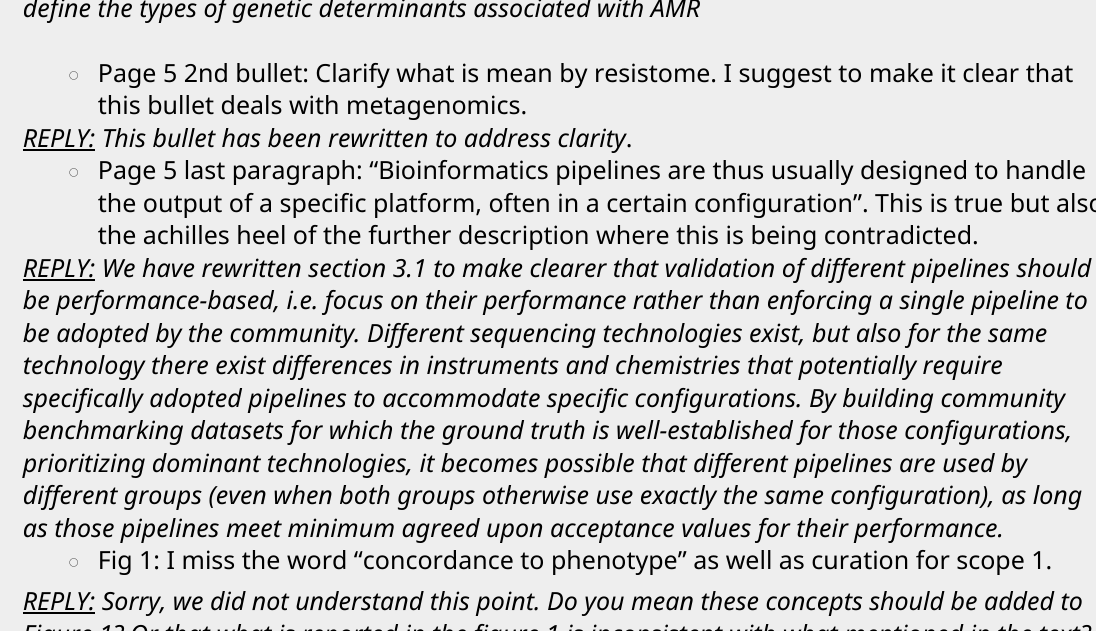
Fig 1: I miss the word “concordance to phenotype” as well as curation for scope 1.